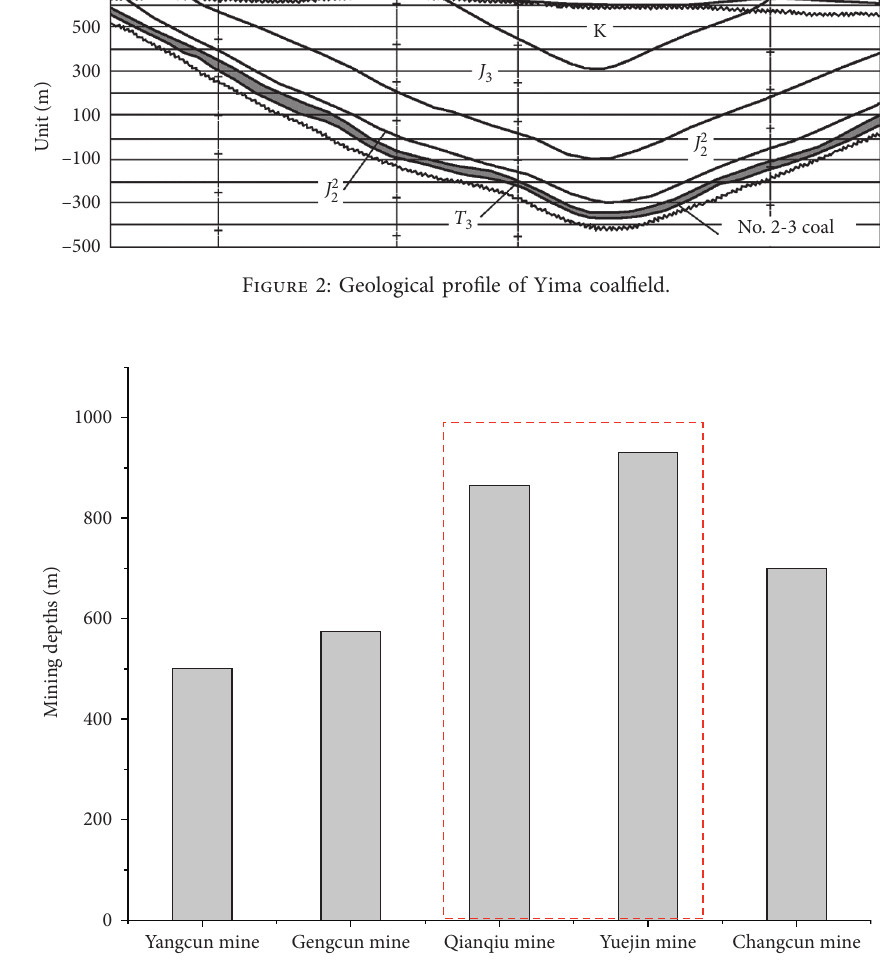
Figure 3: Depth distribution of each mine in Yima